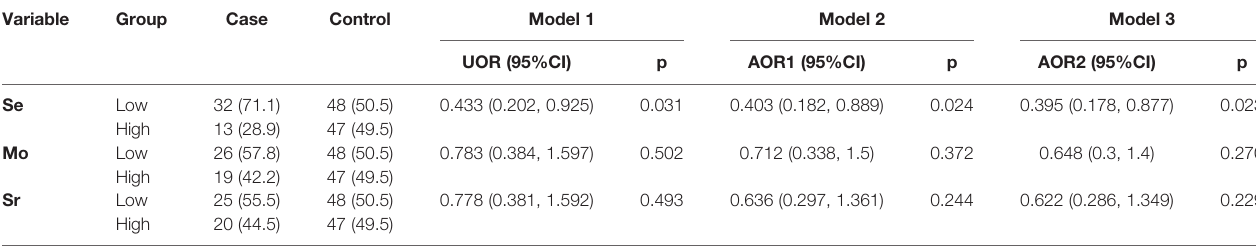
TABLE 3 | Odds ratios (ORs) of Se, Mo, and Sr of serum dichotomized by the corresponding medians of controls. Variable Group